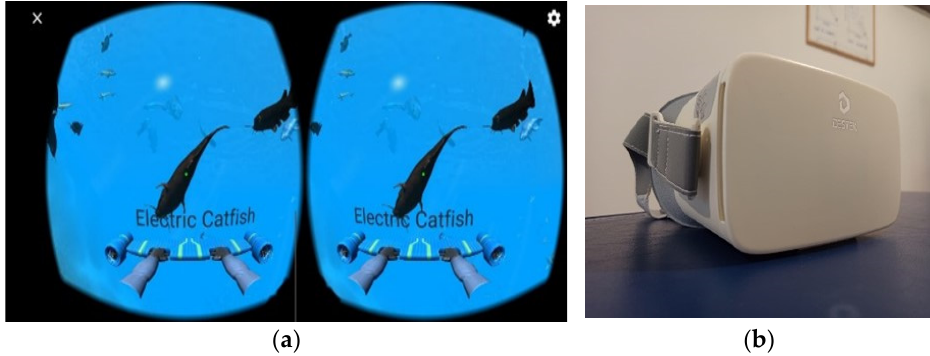
Figure 3. ( a ) VR Ocean Aquarium app. ( b ) Headset for home training (DESTEK Virtual Reality Headset). Table 2. Dosage of the virtual reality exercises for the first week of home treatment.